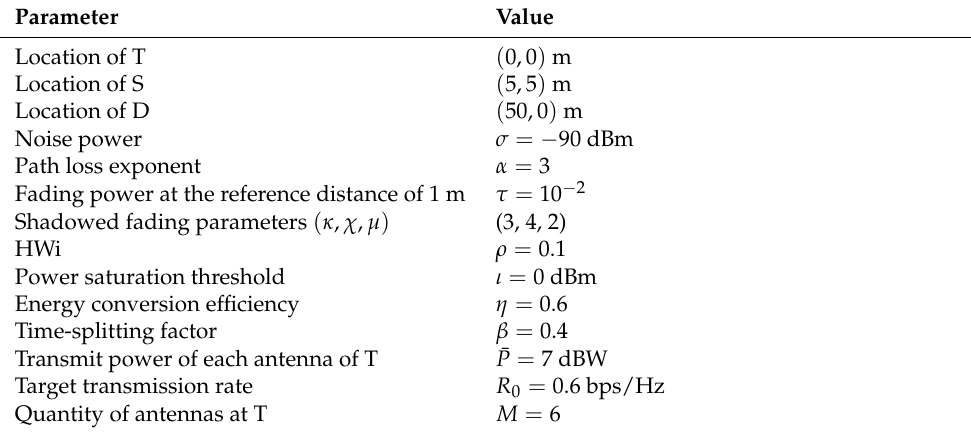
Table 2. Selected parameters unless otherwise